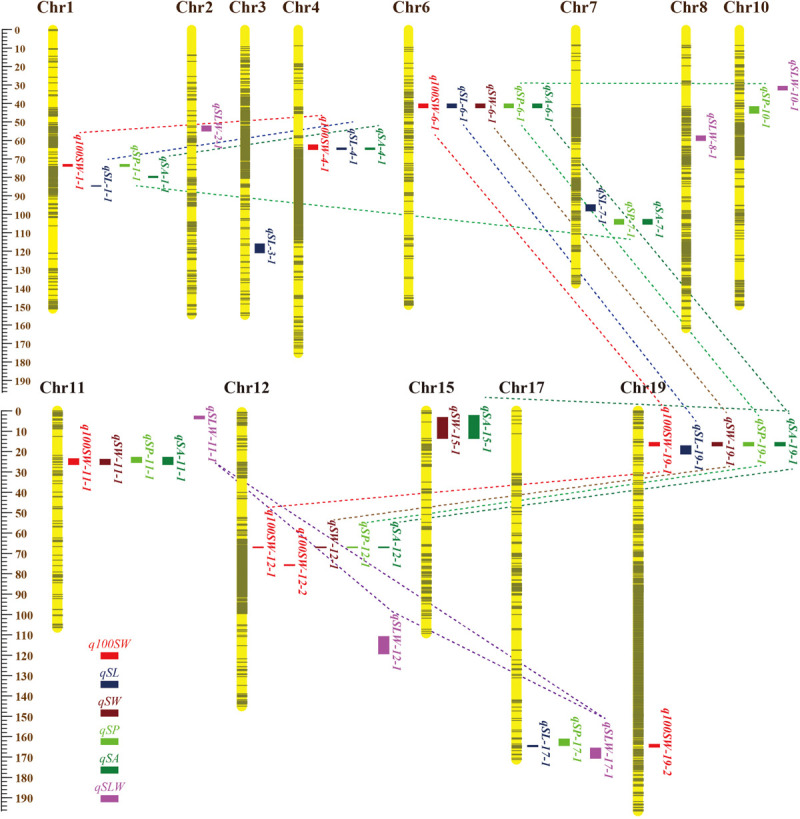
Locations and interactions of QTLs detected for seed traits in NJRISX. Different colorful dot lines represent the interaction between respective QTLs. The ruler on the left is shown in units of cM.